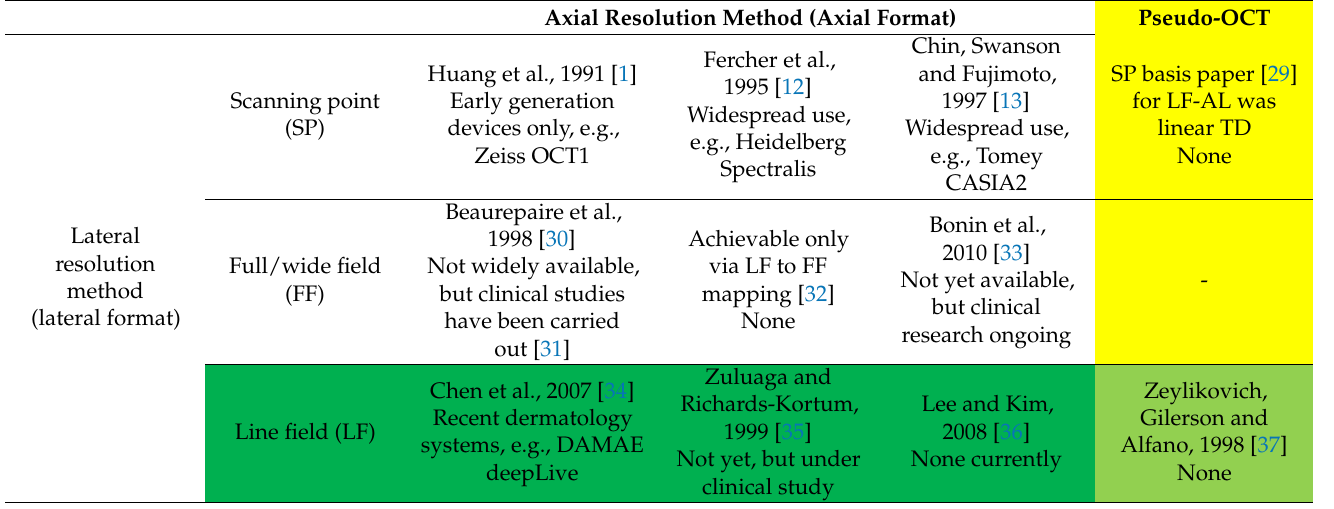
Table 1. Cont. Axial Resolution Method (Axial Format)